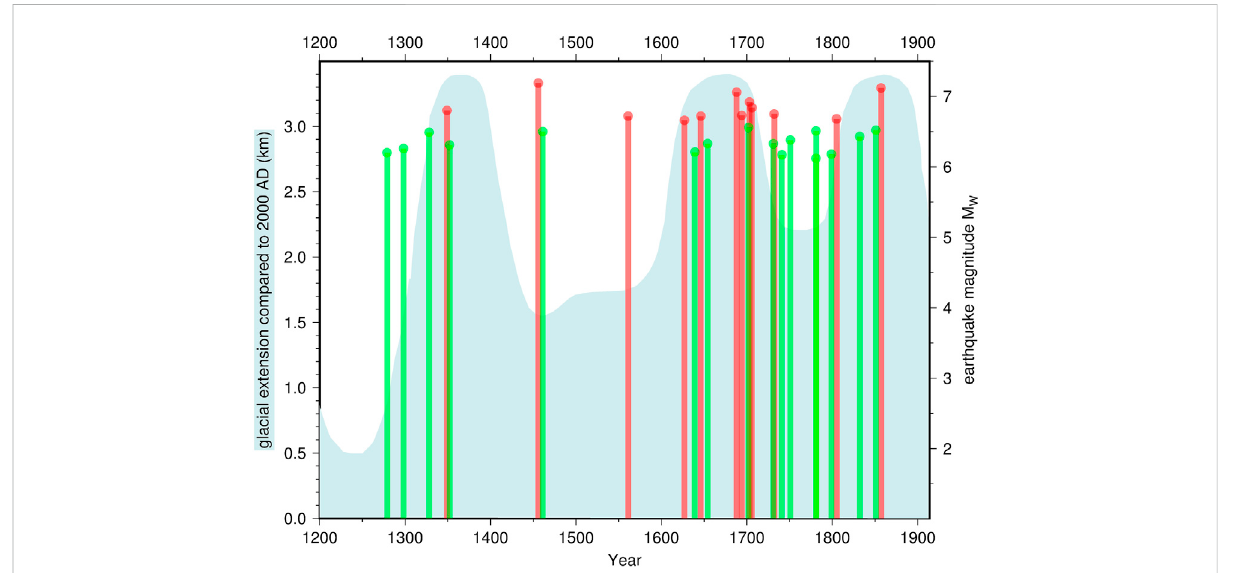
FIGURE 4 Relationship between the occurrence of Mw ≥ 6.1 earthquakes along the Apennines (bars with the height proportional to the magnitude, those with Mw ≥ 6.6 in red and those with Mw < 6.6 in green) and the extension of the Great Aletsch Glacier between 1200 and 1900 AD (light blue